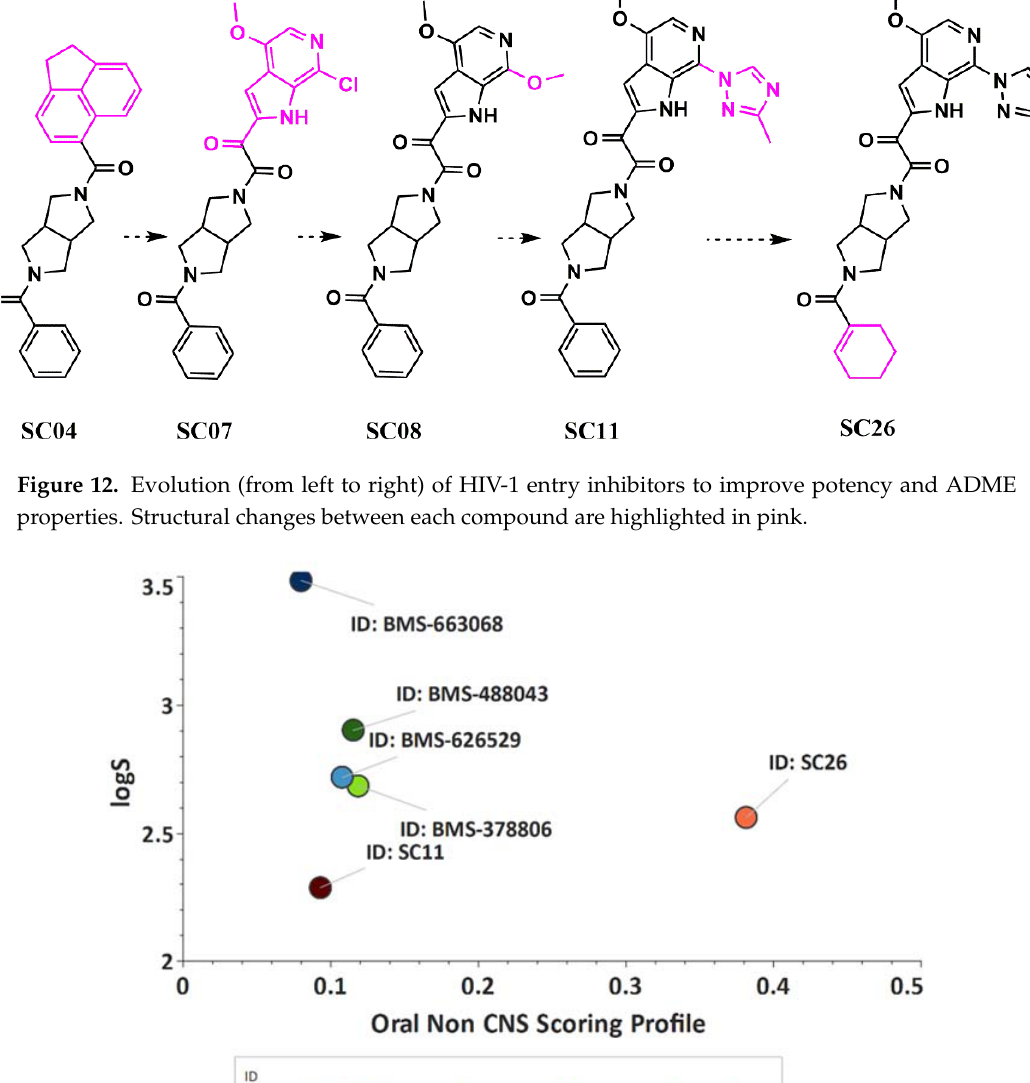
Figure 12. Evolution (from left to right) of HIV ‐ 1 entry inhibitors to improve potency and ADME properties. Structural changes between each compound are highlighted in pink.